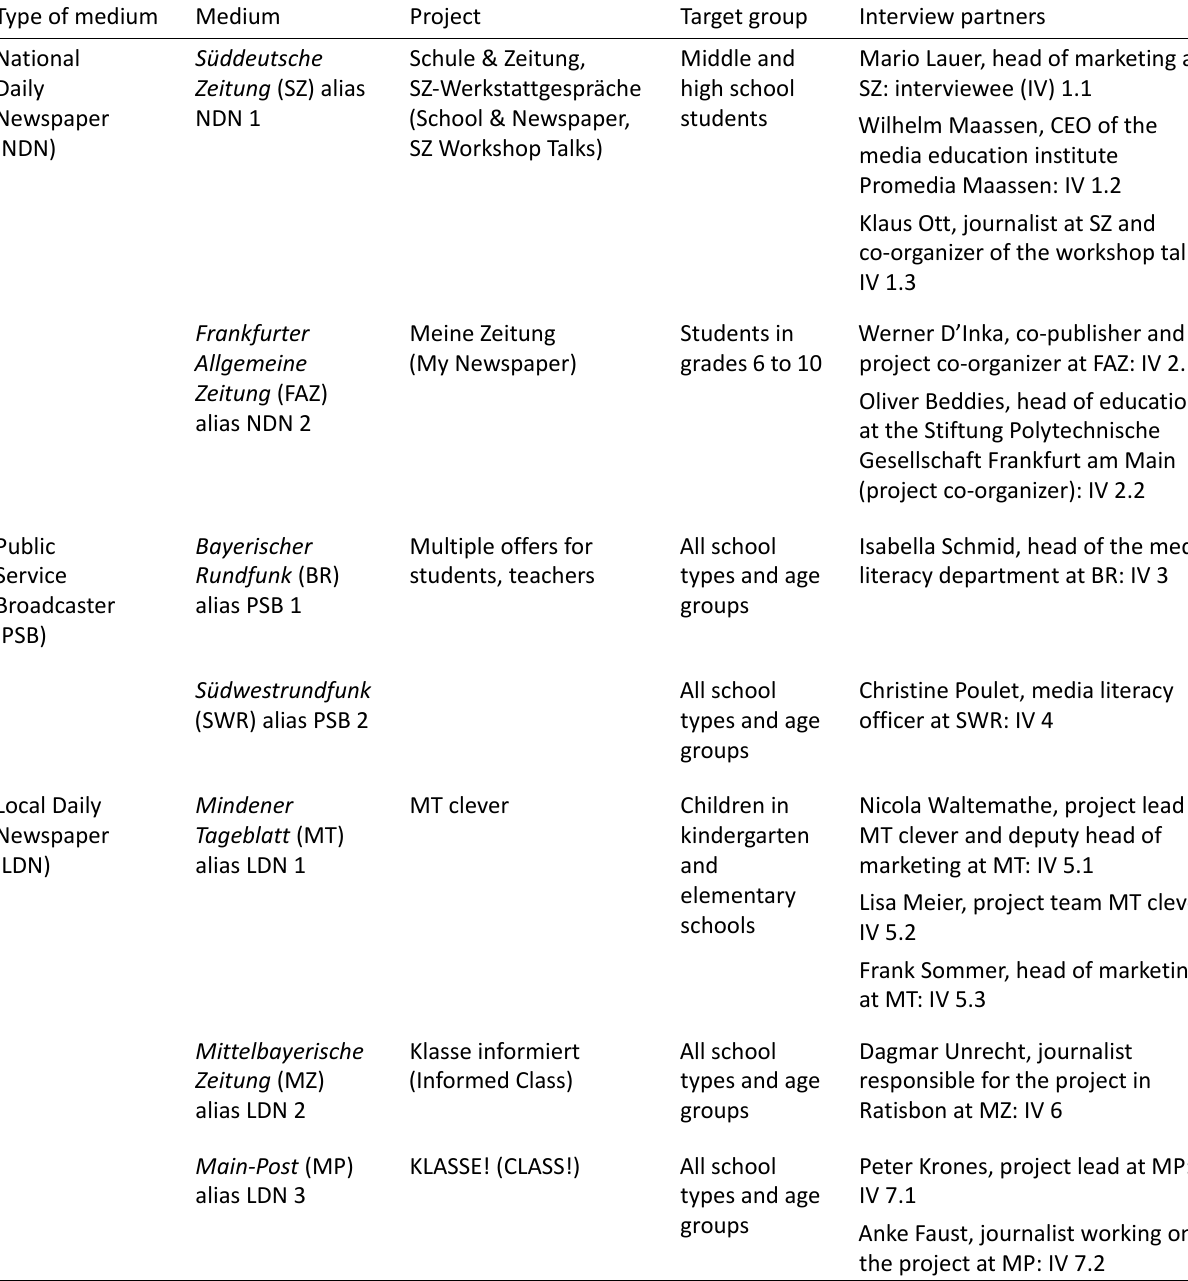
Table 1. Overview of the